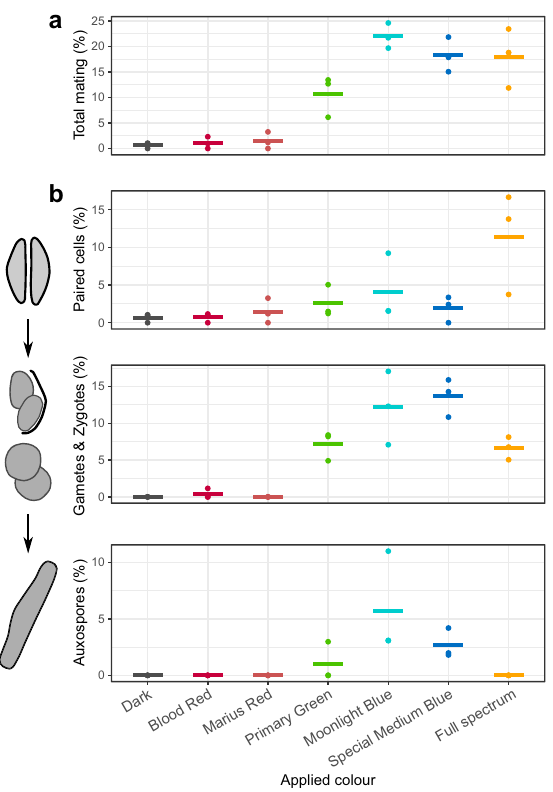
Figure 2. Influence of spectral composition on sexual reproduction. Frequency of mating cells in a crossed culture (PONTON36 x PONTON34) after 14 h of treatment in dark, full spectrum or different wavelength ranges transmitted by the colour filters. Points represent individual replicates, while horizontal lines show the average for each condition. Results are shown for the sum of all sexual cell types (a) and partitioned for each sexual stage (b). Confidence intervals for pairwise statistical tests are visualized in Supplementary Fig.